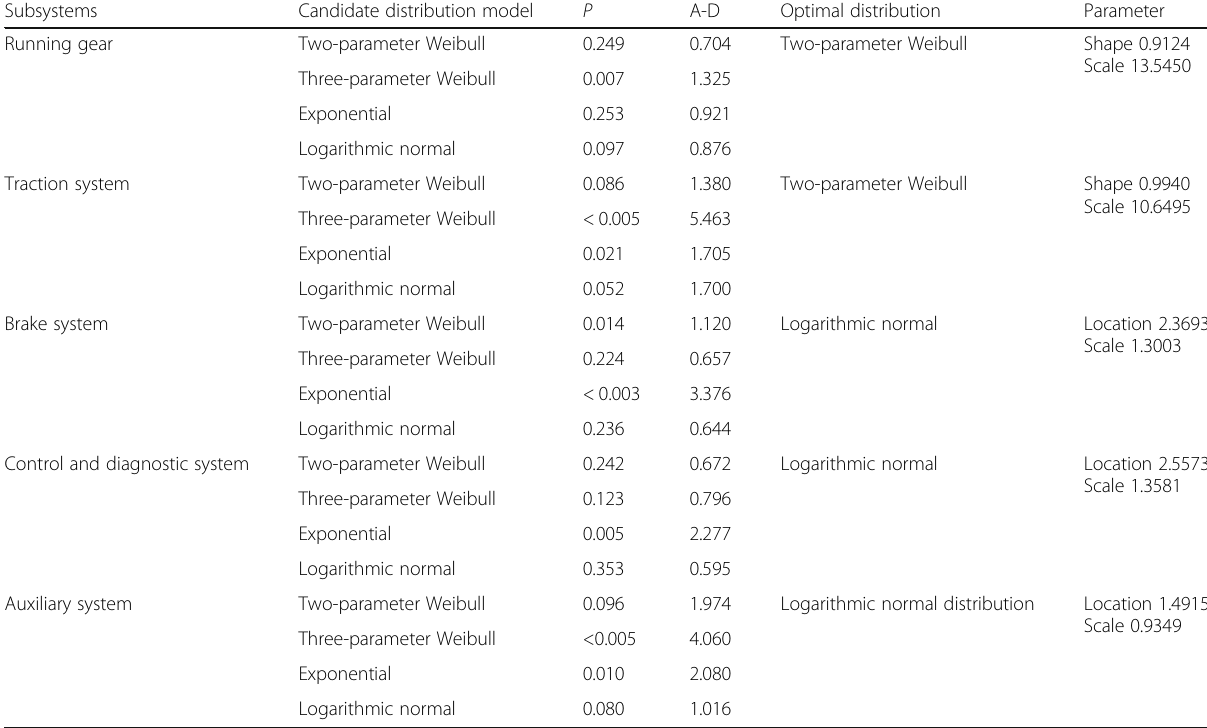
Table 1 Fault distribution fit test table of the key subsystems